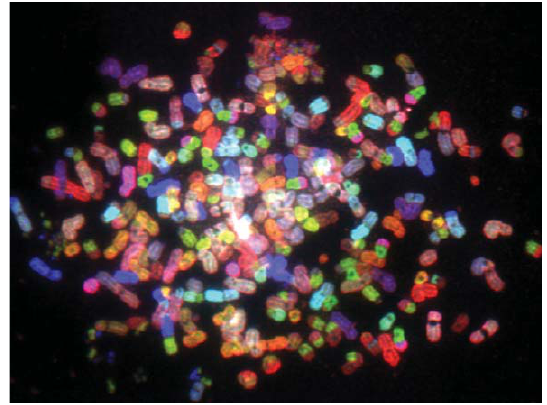
Fig. 11. Spectral karyotype of MDA-MB-435 single cell metaphase with 400 chromosomes. Each chromosome is pseudocolored based on a 5-dye spectral bar